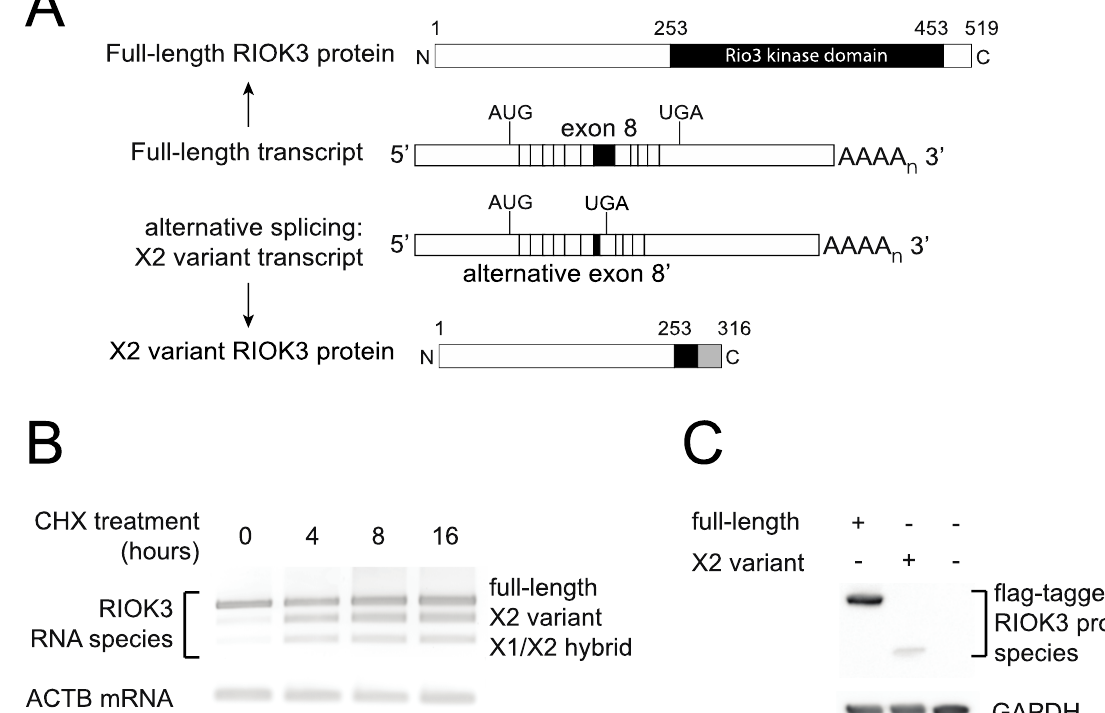
Figure 5. RIOK3 X2 variant mRNA encodes a truncated protein product and is targeted by nonsense-mediated decay (NMD). ( A ) Schematic of the normal and X2 variant alternative splicing on the precursor RIOK3 RNA transcript together with a representation of the full-length and X2 variant RIOK3 protein isoforms. ( B ) Alternatively spliced RIOK3 mRNA is efficiently degraded by nonsense mediated decay. HEK293 cells were mock treated or treated with cycloheximide (CHX) for the times indicated. Total RNA was harvested and subjected to RT-PCR using primers flanking the spliced exons. PCR products were run on agarose and stained using ethidium bromide. As CHX inhibits NMD, X2 and X1/X2 products are preserved with treatment. Actin B was used as a control. ( C ) Expression of RIOK3 full-length and X2 variant proteins from transfected expression plasmids. RIOK3 full-length and X2 constructs were transfected into HEK293 cells and expression was analyzed by Western blot. The presence of the same FLAG tag at the N-terminus of both proteins allowed us to compare their expression efficiencies.